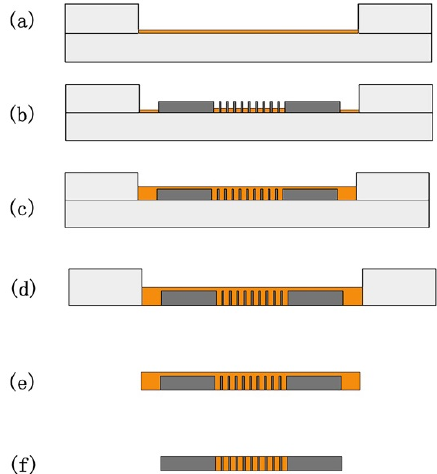
Figure 2. 3D coil manufacturing steps with double-sided filling method: ( a ) fix the trenched quartz glass plate to the bottom plate and pour a layer of powder; ( b ) place the dies with solenoid cavities over the powder; ( c ) continue pouring the powder until it completely covers the silicon structure; ( d ) after vibrating and sintering, separate the upper and lower quartz glass plates; ( e ) remove the sample; ( f ) a sintered coil can be obtained after surface lapping cleaning. Table 1. Types and properties of powders.